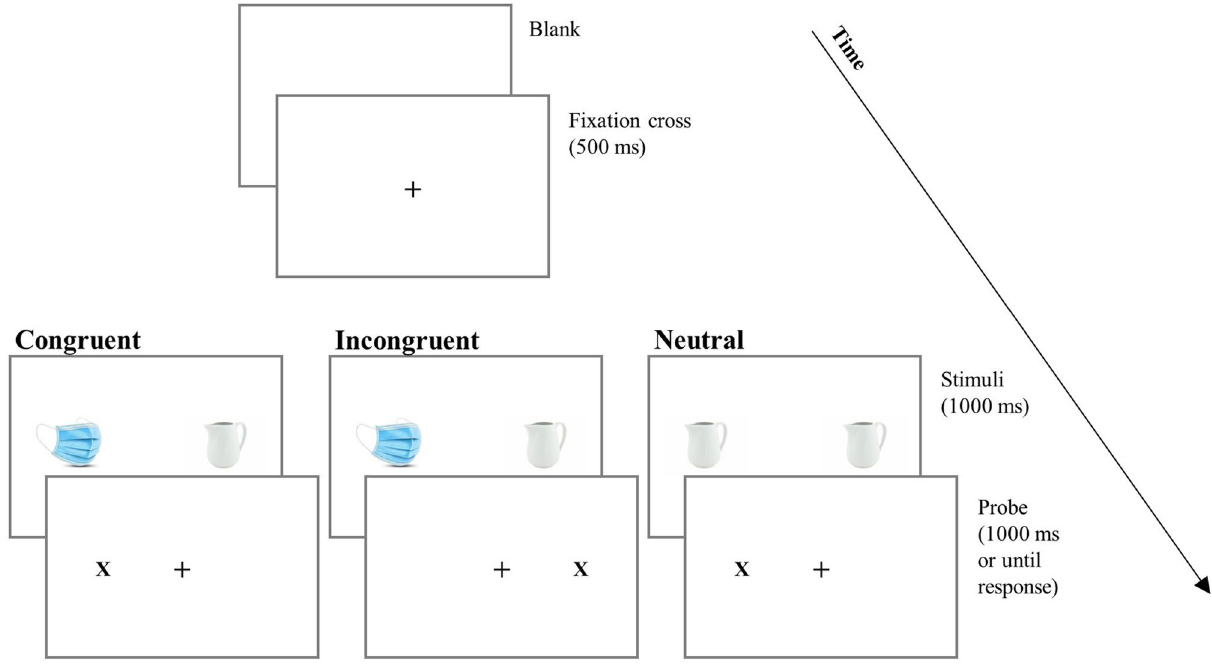
Figure 2. Trial structure and experimental conditions in the visual dot probe week of April (from April 23rd to April 29th, 2020). On average, the experimental session lasted 5.6 min ± 2.6 SD. Based on Miller & Fillmore (2010), the script implemented a visual dot-probe procedure to measure attentional